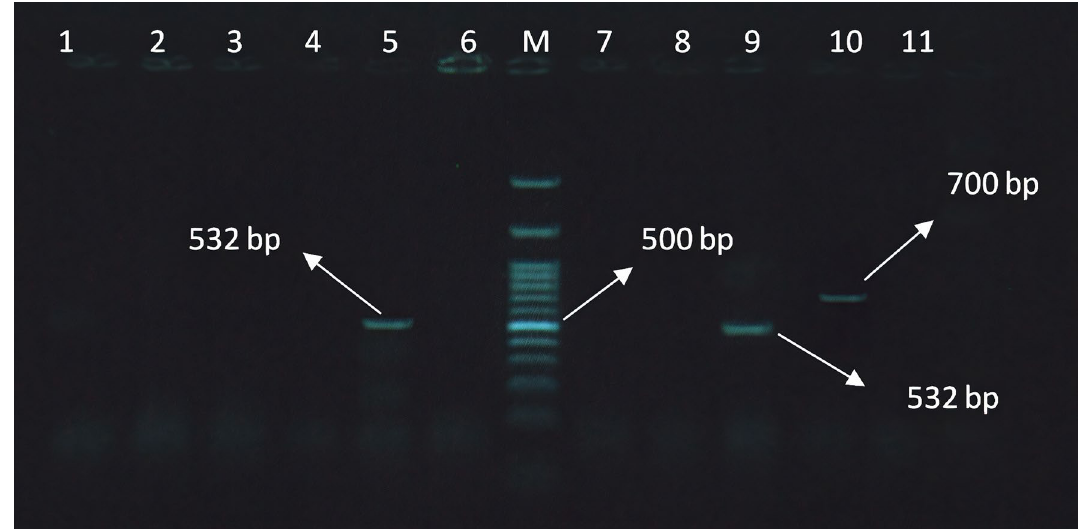
Figure 3. Electrophoresis pattern obtained by multiplex PCR for detection of mec A and bla Z genes in S. aureus isolates. M: marker 100 bp; Lanes 5 and 9: amplification of mec A gene at 532 bp; lane 10: amplification of bla Z gene at 700